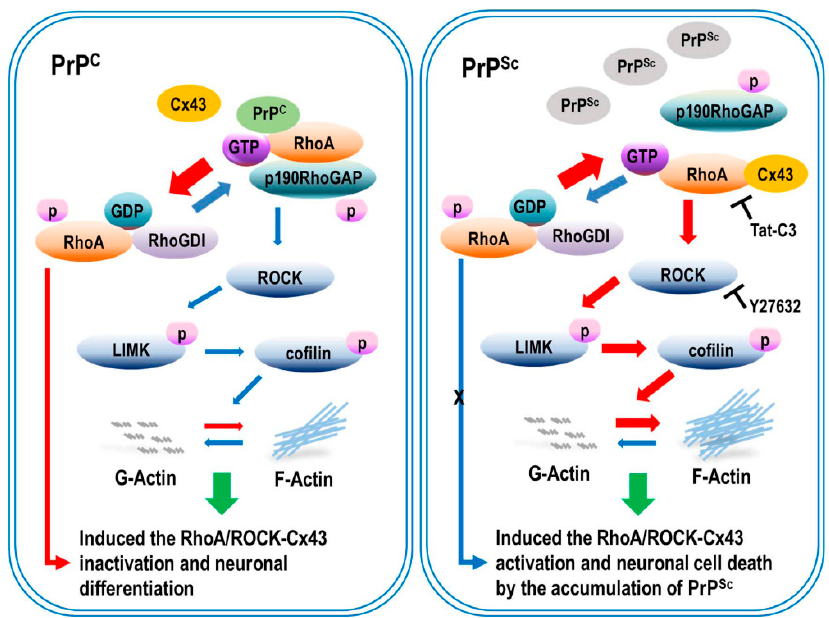
Figure 8. Scrapie infection regulated the activation of RhoA/ROCK-Cx43 signaling and affected PrP Sc accumulation and hemichannel function. Scrapie infection decreased the phosphorylation of RhoA, reducing the interaction between RhoA and p190RhoGAP, leading to the activation of RhoA and its downstream effector proteins. Moreover, scrapie infection increased PrP Sc accumulation and hemichannel function. Subsequently, RhoA/ROCK-Cx43 activation enhanced actin polymerization and decreased neurite outgrowth. However, inhibition of RhoA/ROCK signaling prevented the activation of Cx43 and reduced the interaction between RhoA and Cx43, which prevented RhoA/ROCK activation, PrP Sc accumulation, and hemichannel function by interfering with the interactions.